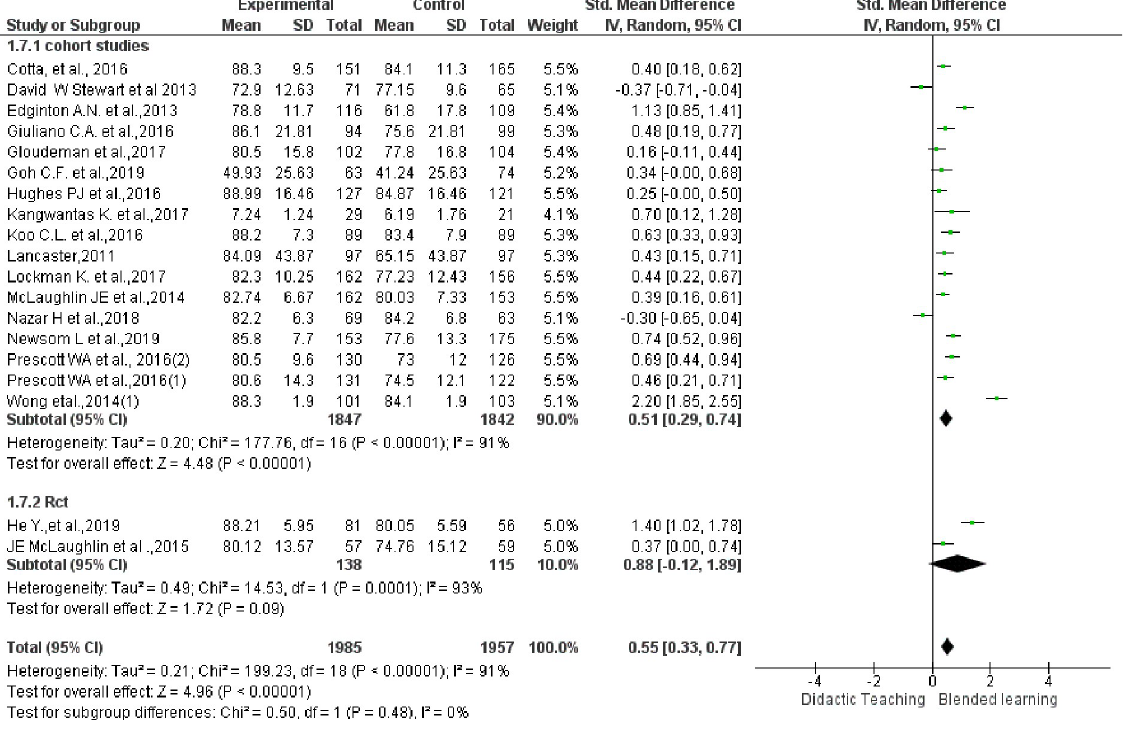
Fig 4. Sensitivity analysis: If more than one topic was delivered by BL in same study (Prescott, Wong) with separate scores for each, we considered them as separate studies (Prescott 1&2).